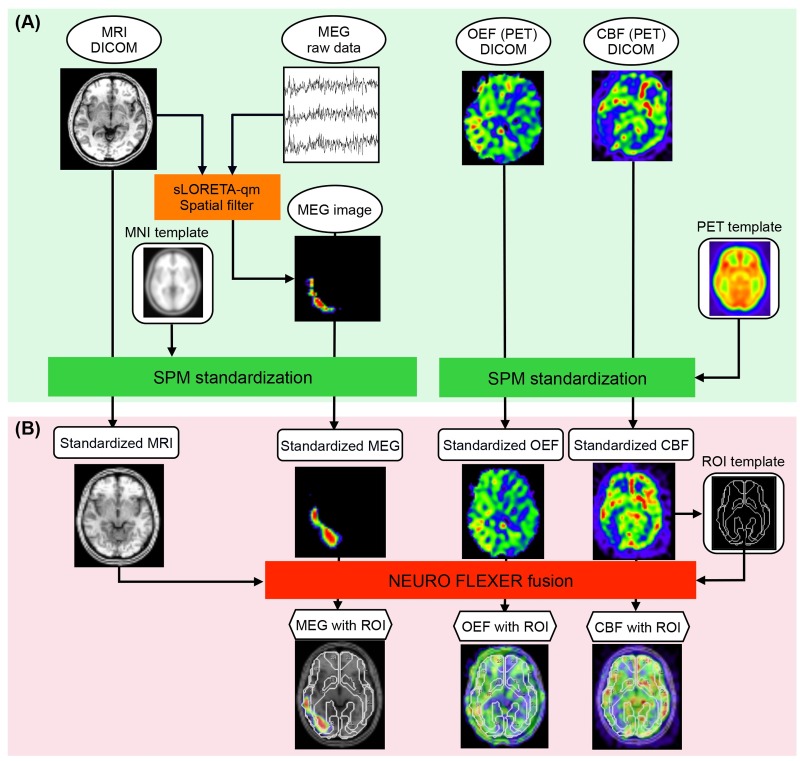
Pipelines for automated ROI setting for quantitative images of PET and MEG.(A) The first step was standardization using SPM. A MEG source image was acquired using a sLORETA-qm spatial filter from the slow spontaneous magnetic fields. MRI-T1WI, CBF in the PET image, and the MEG source image were spatially standardized by SPM using a pre-ordered template of MRI-T1WI and CBF in PET. OEF in the PET image was also standardized by SPM using the template of CBF in PET. (B) The second step was automated ROI constitution using NEUROFLEXER. The pre-ordered ROI template can be applied to the different modalities e.g., MEG and PET, through the normalized MRI.